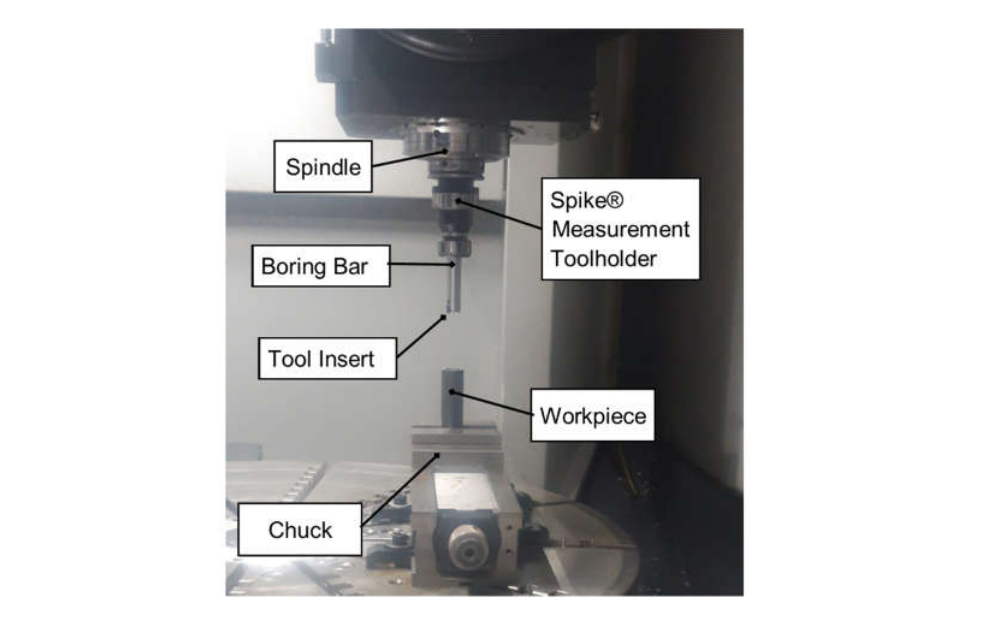
Figure 5. Setup of LFAB operation. Table 2. Conventional cutting conditions. LFAB cutting